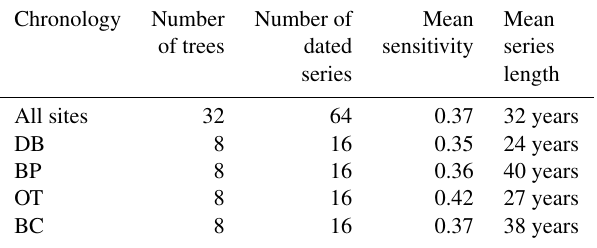
Table 4. Series intercorrelation values calculated using chronolo- gies from individual cores and tree level means across all sites and within each